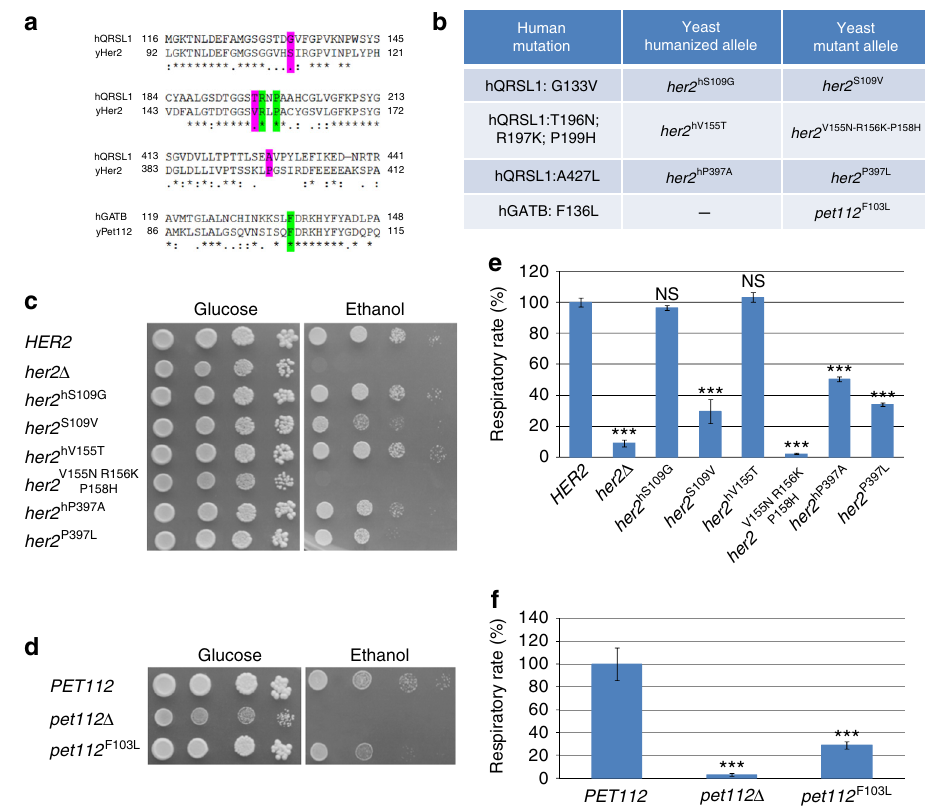
Fig. 7 Modeling of the QRSL1 and GATB ( PET112 ) variants in Saccharomyces cerevisiae . a Partial alignment (Clustal Omega) of the human GatA ( QRSL1 ) and the yeast Her2 proteins, and the human GatB and yeast Pet112 proteins, respectively. The studied residues are highlighted in green for conserved amino acids, and in magenta for non-conserved. Amino acids are indicated as conserved (*), with strongly similar properties (:) or with weakly similar properties (.). b Amino acid changes found in the patients and the corresponding humanized and mutant yeast alleles. c – d Oxidative growth: the her2 Δ and pet112 Δ strains harboring wild-type alleles, humanized or mutant alleles, or the empty vector were serially diluted and spotted on synthetic complete agar plates supplemented with 2% glucose or 2% ethanol in presence ( c ) or in absence ( d ) of the amide donor glutamine, and incubated at 28 °C ( c ) or 37 °C ( d ). High temperature (37 °C) and absence of glutamine were used to exacerbate the pet112 phenotype. A growth defect in obligatory respiratory medium is evident for the mutants. e – f Oxygen consumption rates: cells were grown at 28 °C ( e ) or 37 °C ( f ) in SC medium supplemented with 0.6% glucose in presence ( e ) or in absence ( f ) of glutamine. Values were normalized to the appropriate wild-type strain. The data are the results of at least three measurements, and the error bars indicate the standard deviation. Statistical analysis was performed by paired, two-tail Student ’ s t test comparing mutant strains to wild-type (for PET112 ) or humanized (for HER2 ) strains, and the humanized her 2 strains to the corresponding HER2 wild-type strain: *** p